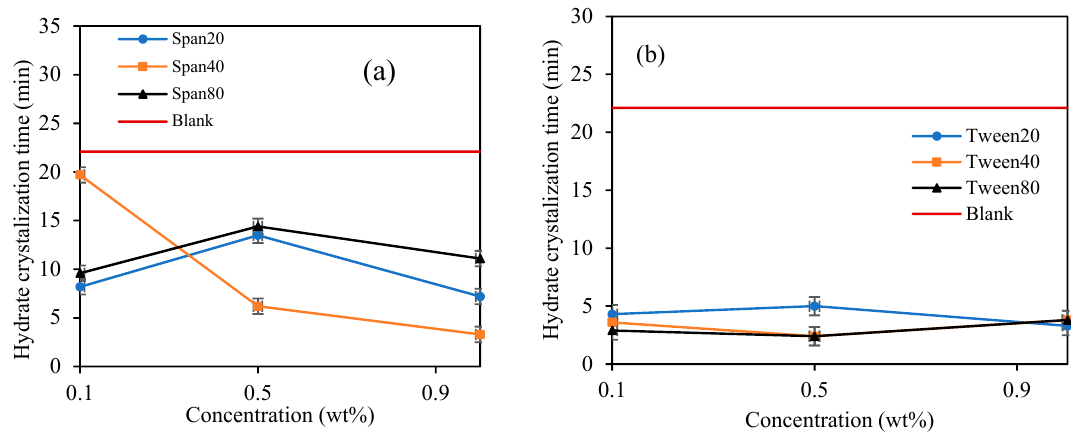
Figure 9. The e ff ect of Span and Tween concentrations (% v / v ) on CP–hydrate formation crystallization Figure 9. The effect of Span and Tween concentrations (% v/v ) on CP–hydrate formation time. 50 / 50; aging temperature 2.0 deg C); ( a ) Span surfactants, ( b ) Tween crystallization time. 50/50; aging temperature 2.0 deg C); ( a ) Span surfactants, ( b ) Tween surfactants.